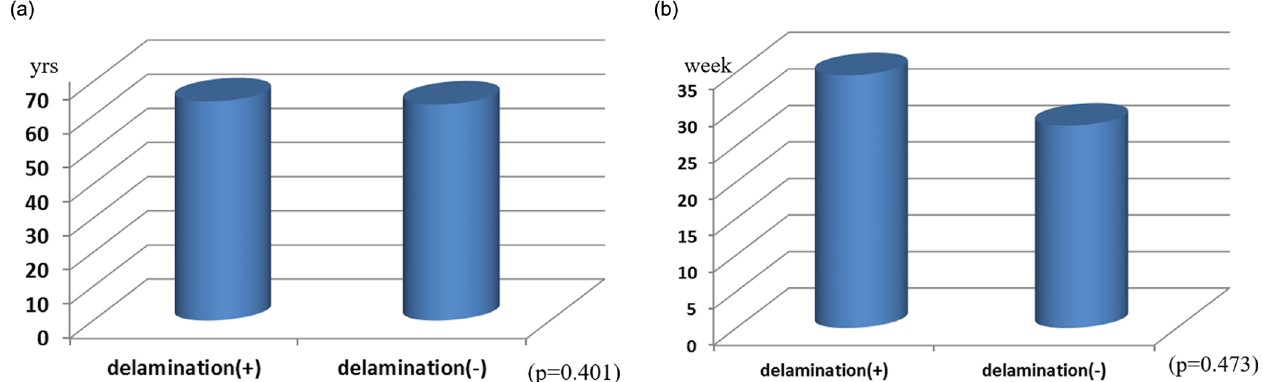
Figure 2. (a) Relation between delamination and age. (b) Relation between delamination and duration of